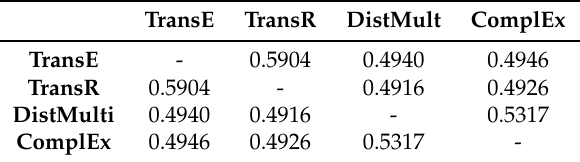
Table 3. Spearman’s rank correlation coefficients among the knowledge graph